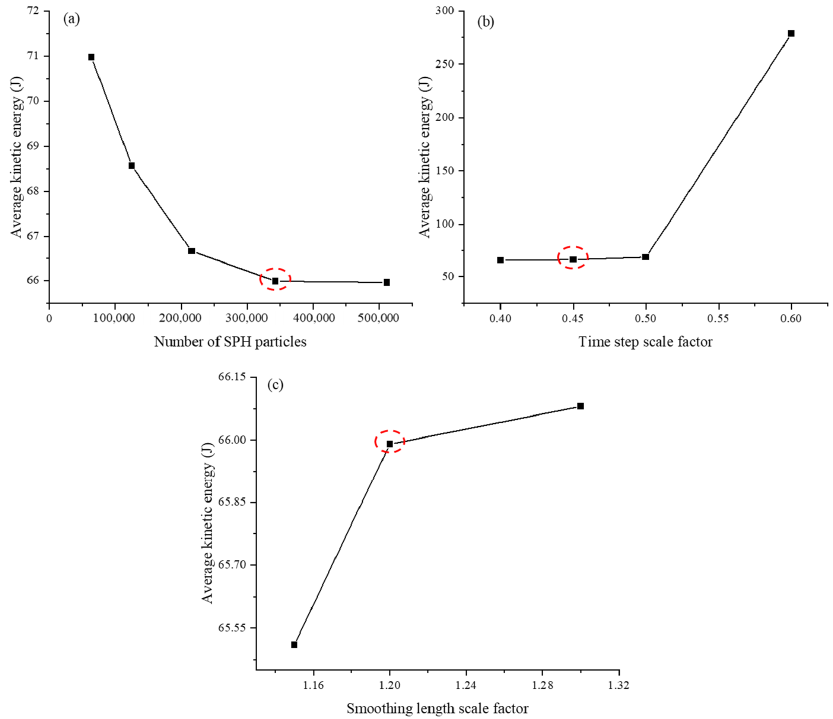
Figure A4. Convergence of average kinetic energy of tailings flow under different numerical parameters. ( a ) Mesh independence; ( b ) time step scale factor; ( c ) smoothing length scale factor.